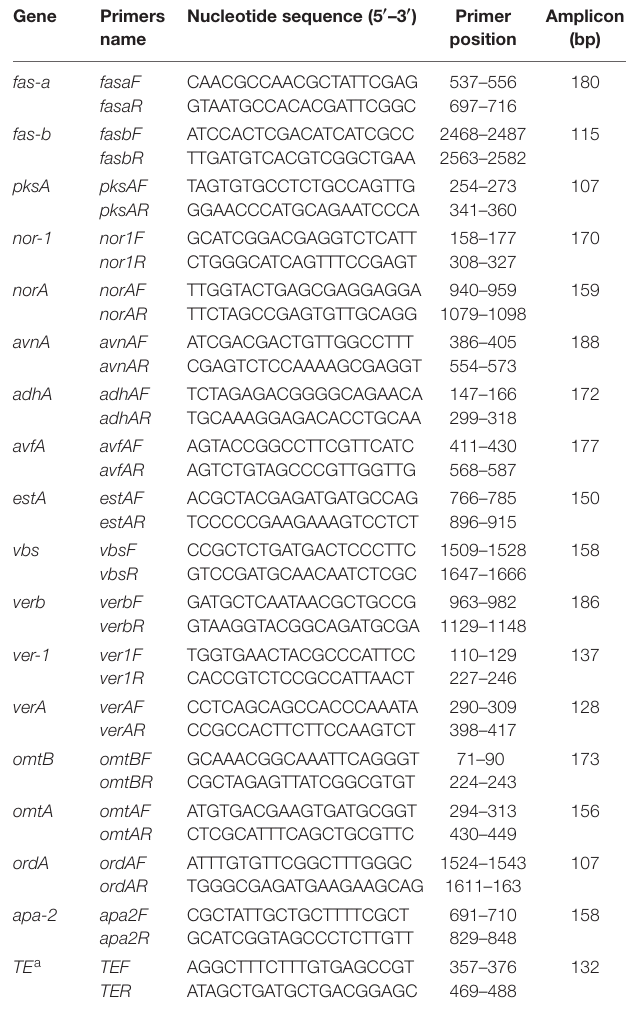
TABLE 1 | Primers used for the transcriptional analysis of AF-biosynthesis cluster